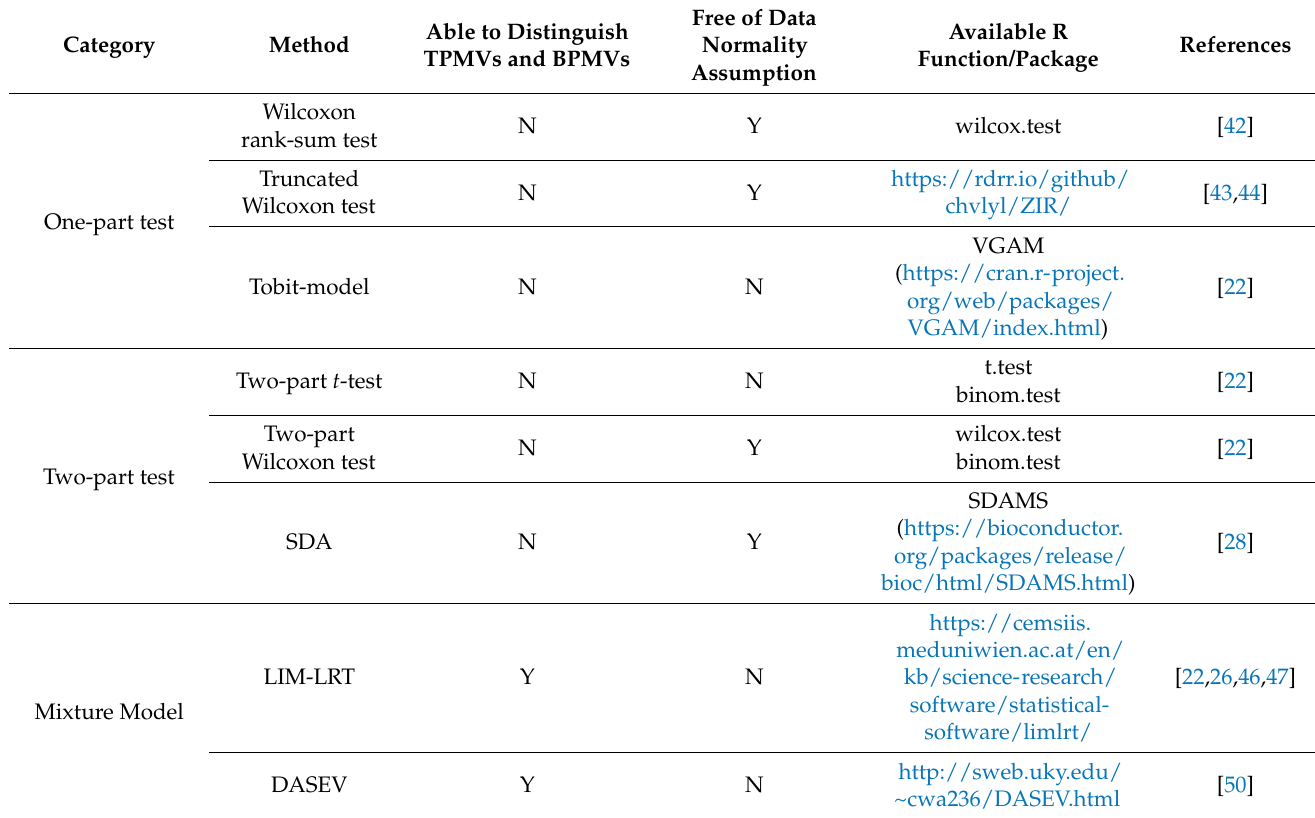
Table 1. Comparison of statistical methods for DA